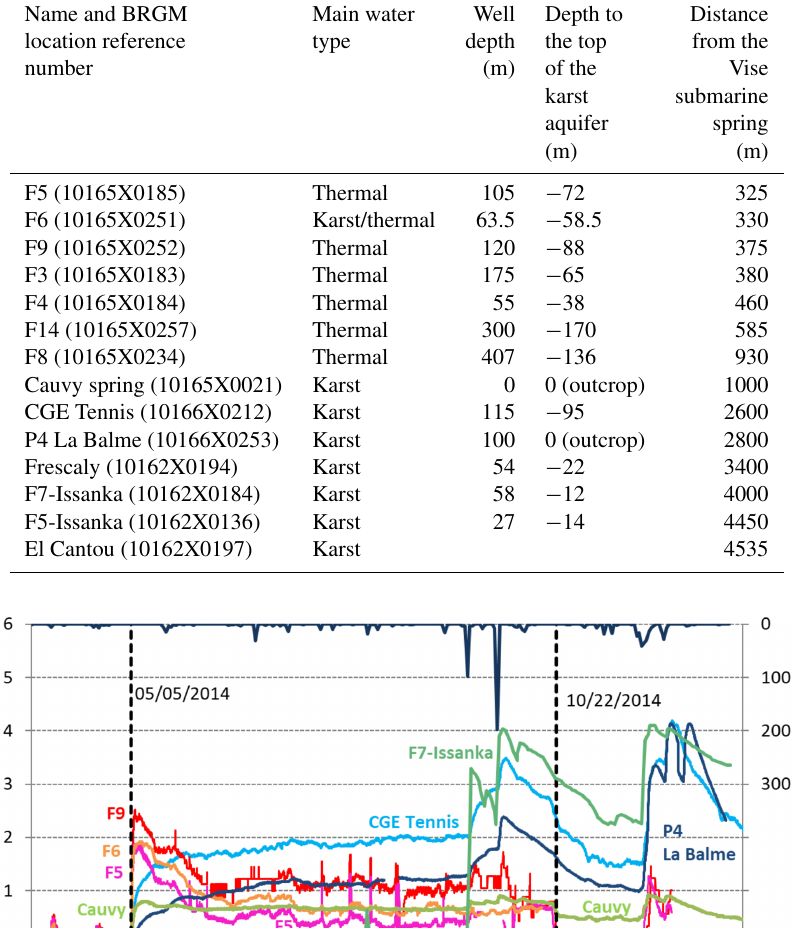
Table 3. Characteristics of the main wells and springs in the study area.